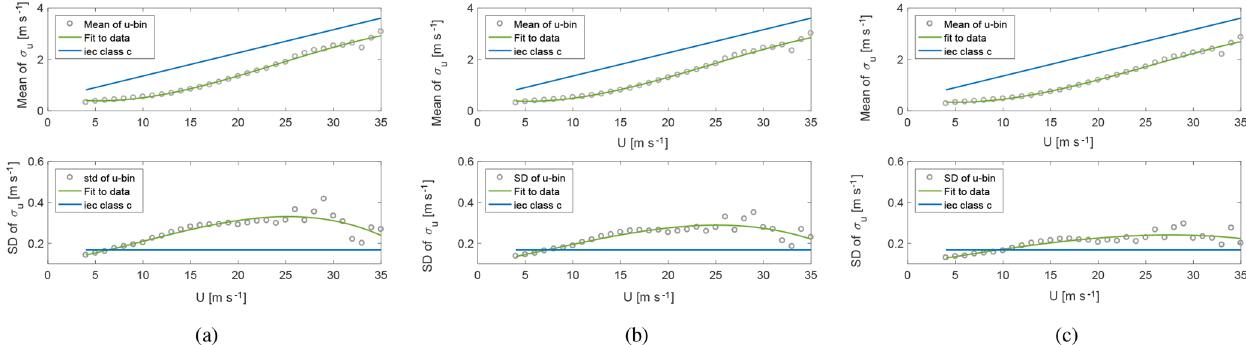
Figure A1. Notation is the same as Fig. 4 but for (a) linearly detrended data, (b) high-pass-filtered data with a cutoff frequency of 1 / 600Hz, and (c) high-pass-filtered data with a cutoff frequency of 1 /